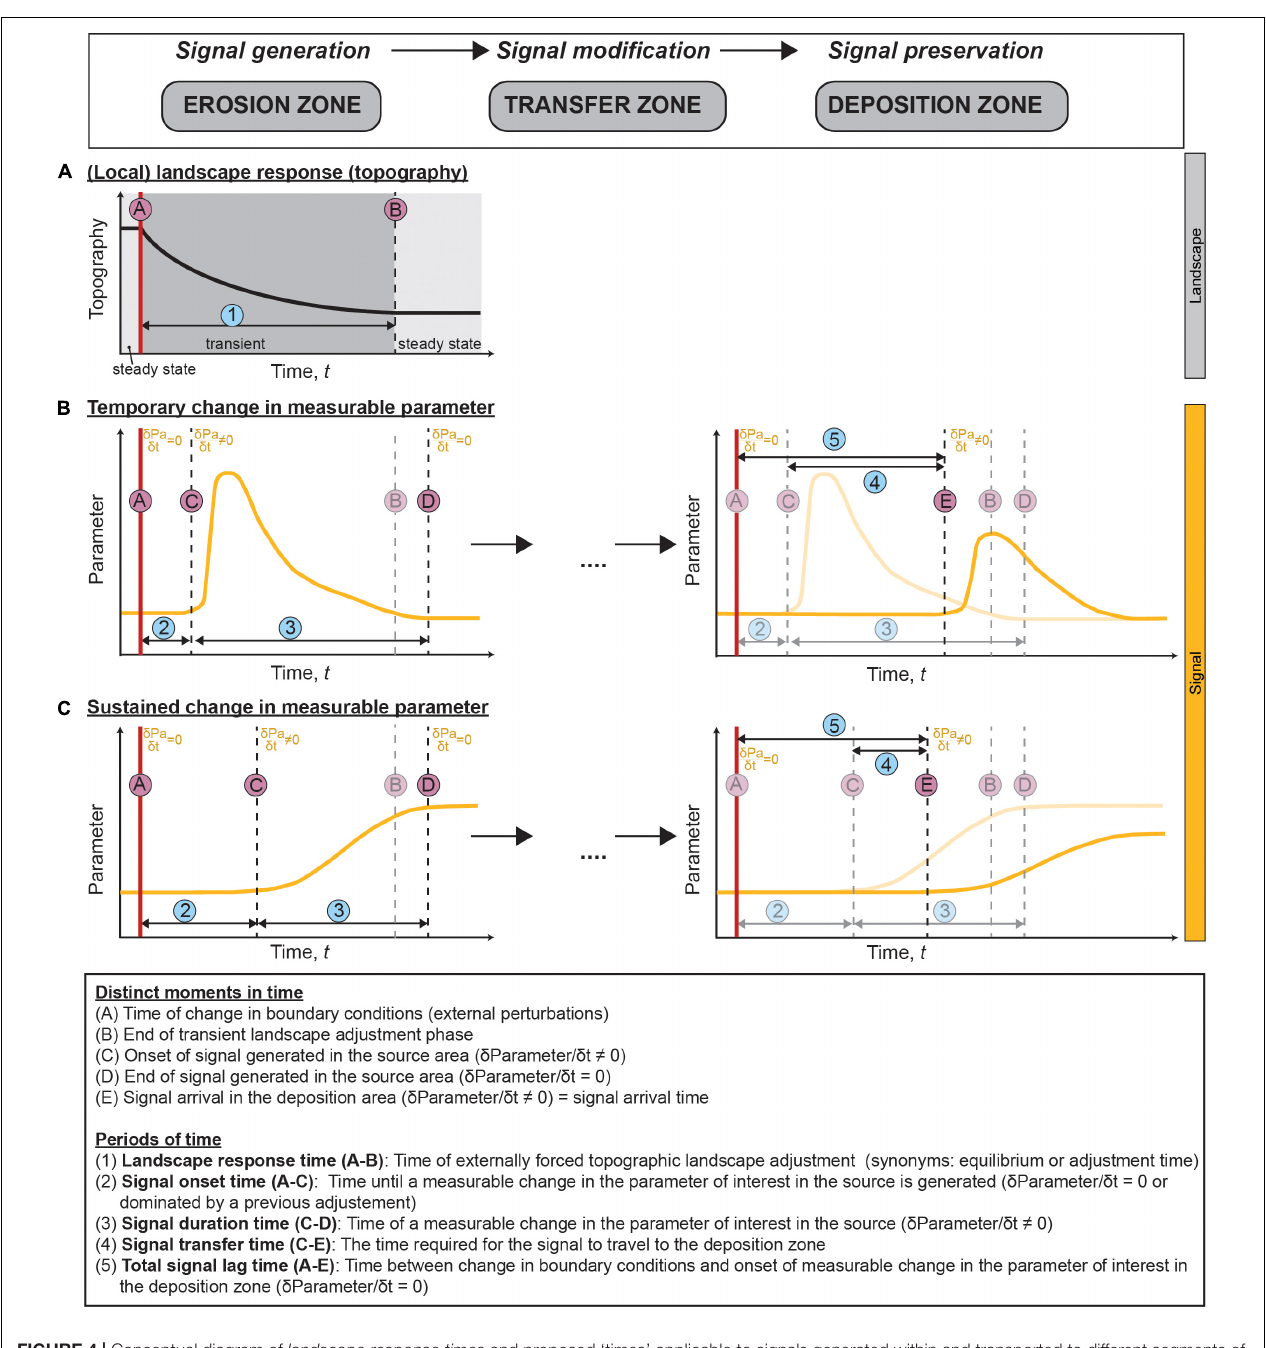
FIGURE 4 | Conceptual diagram of landscape response times and proposed ‘times’ applicable to signals generated within and transported to different segments of SRSs. Changes in boundary conditions (vertical red line) cause a topographic response in the landscape (A) and the generation of signals (B,C) . Exemplary, the proposed times are described on the two endmembers of signal shapes – temporary (B) or sustained (C) changes in the parameter of interest (e.g., Allen and Densmore, 2000; Bonnet and Crave, 2003; Armitage et al., 2011). The shape of the topographic response and signal curves is based on a range of previous studies (see text for details). We distinguish between distinct moments in time (letters) and periods of times (numbers) for both topographic and sediment parameter changes. For detailed explanations on the different types of time see main